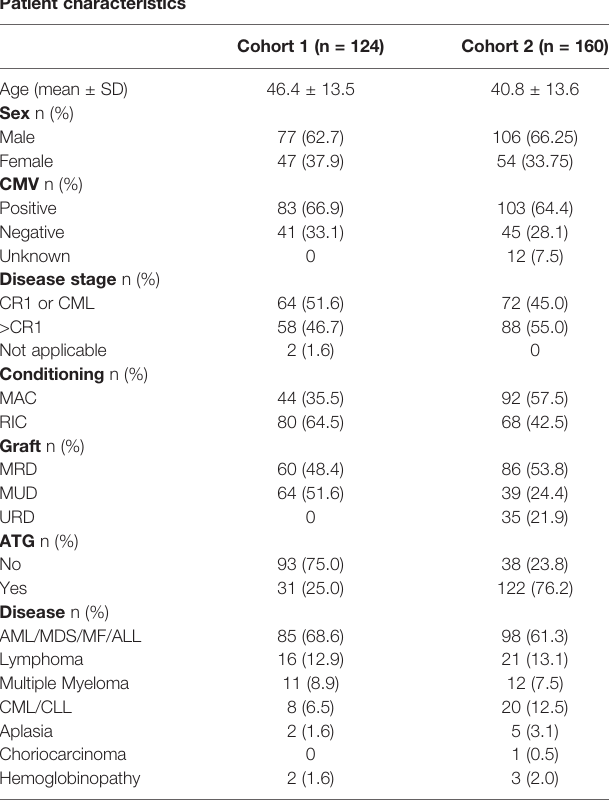
TABLE 1 | Patient